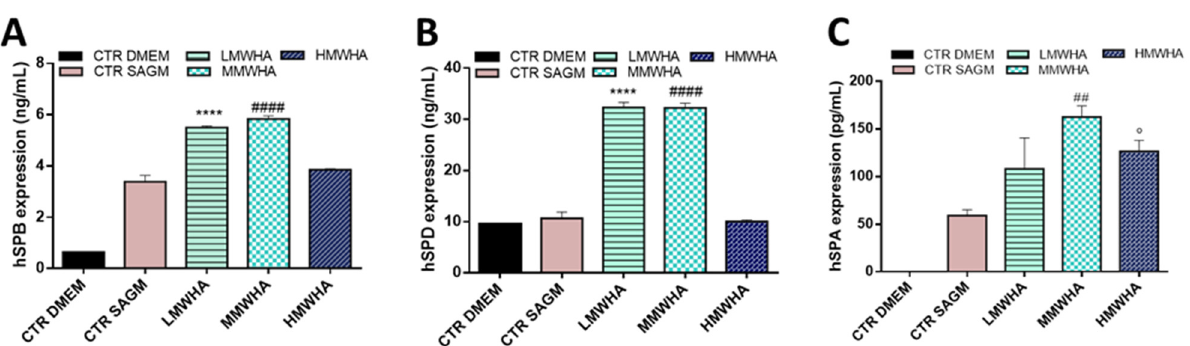
Figure 4. Quantitative expression of SPB ( A ), SPD ( B ) and SPA ( C ) performed by Elisa test. Results are mean ± of 3 experiments. **** p < 0.001 vs. Control SAGM, #### p < 0.001 vs. Control SAGM, ## p < 0.001 vs. Control SAGM, ◦ p < 0.001 vs. Control SAGM.